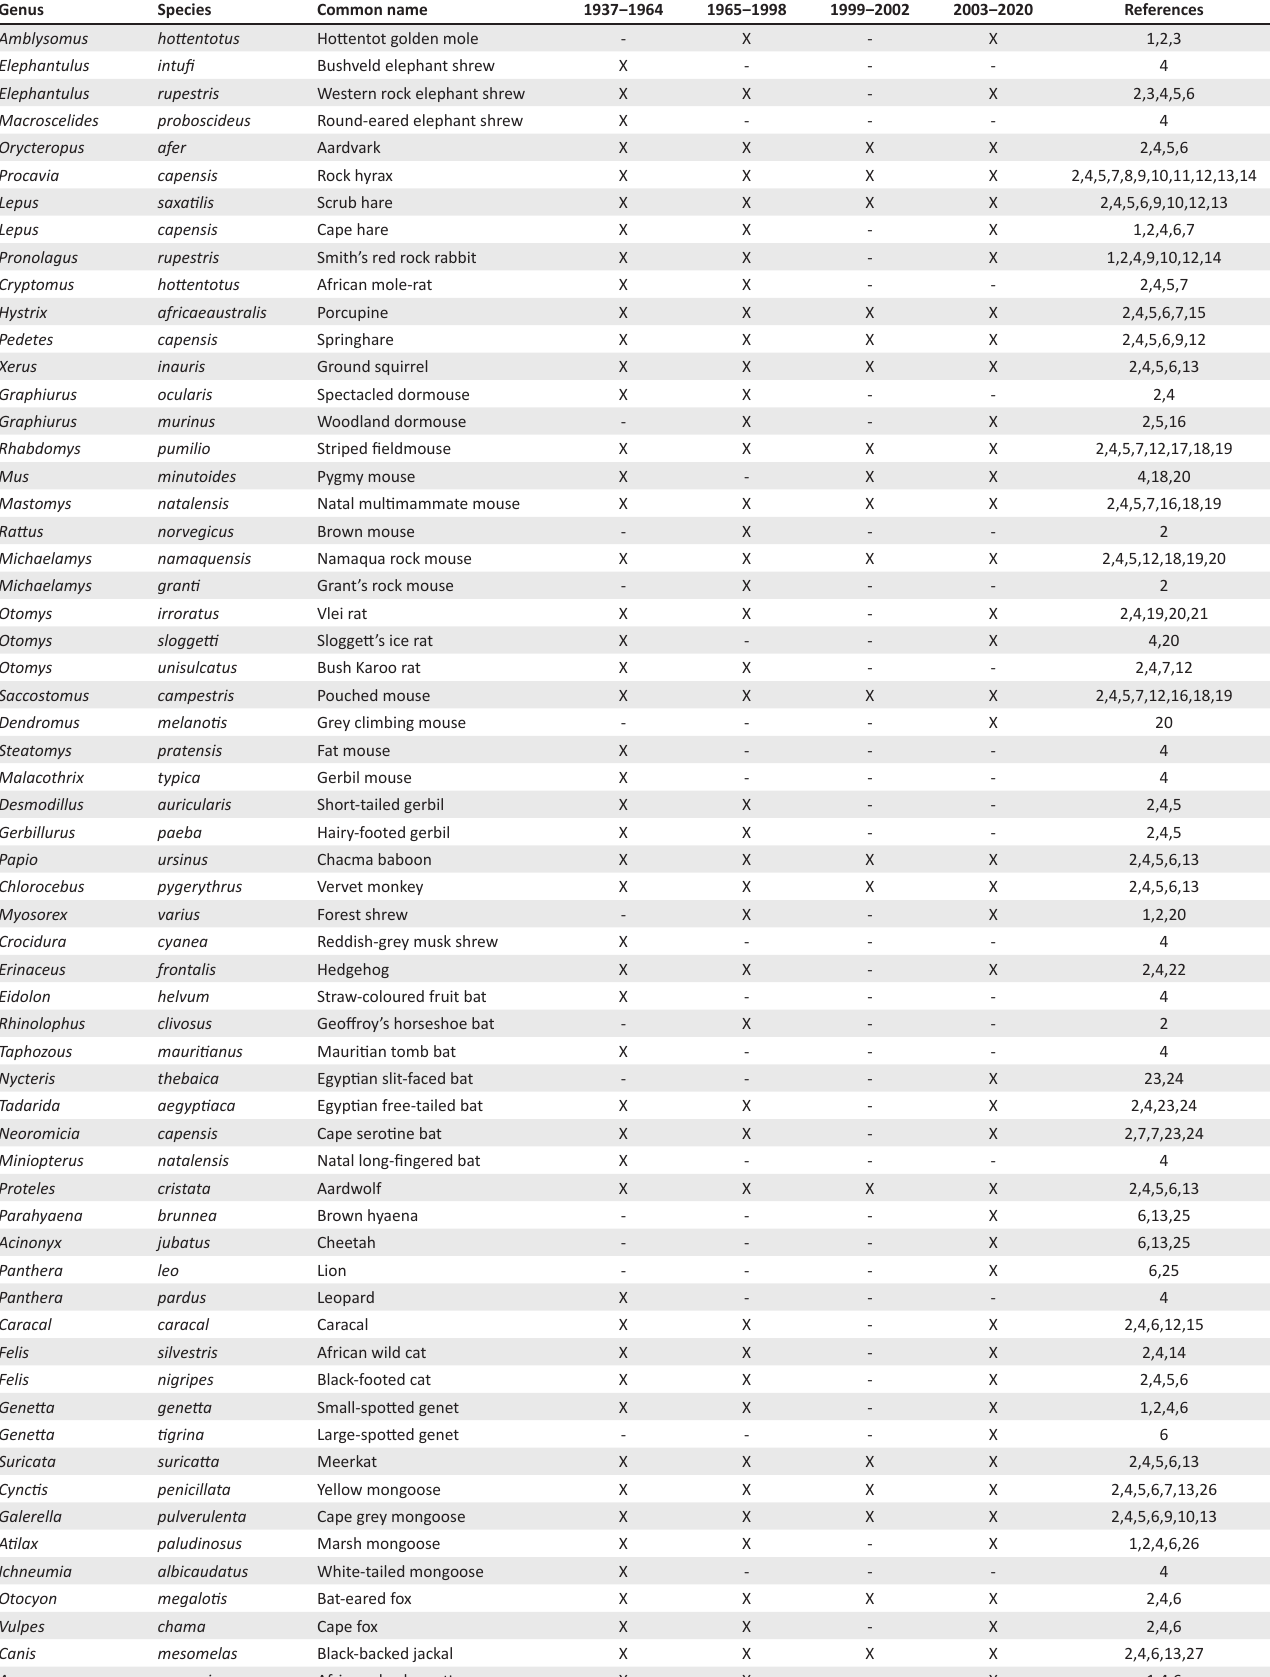
TABLE 1: The mammal species recorded at Mountain Zebra National Park between 1937 and 2020.